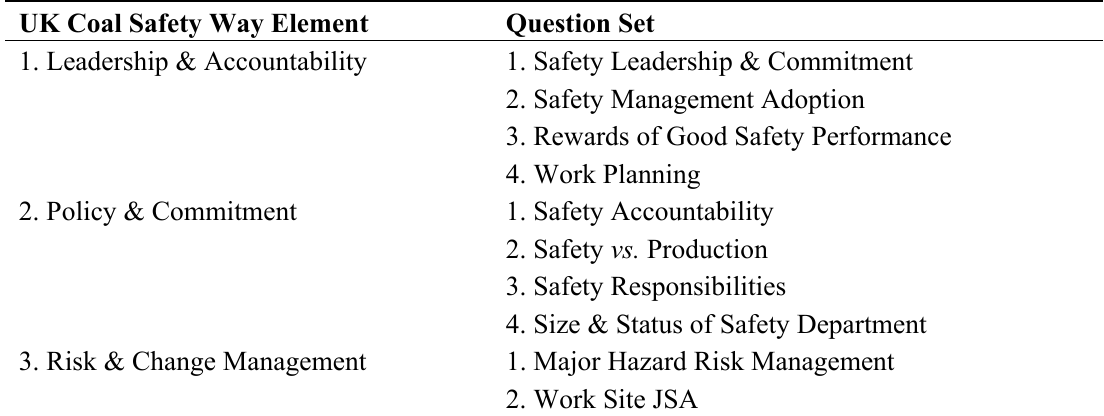
Table 2. UK Coal maturity model question